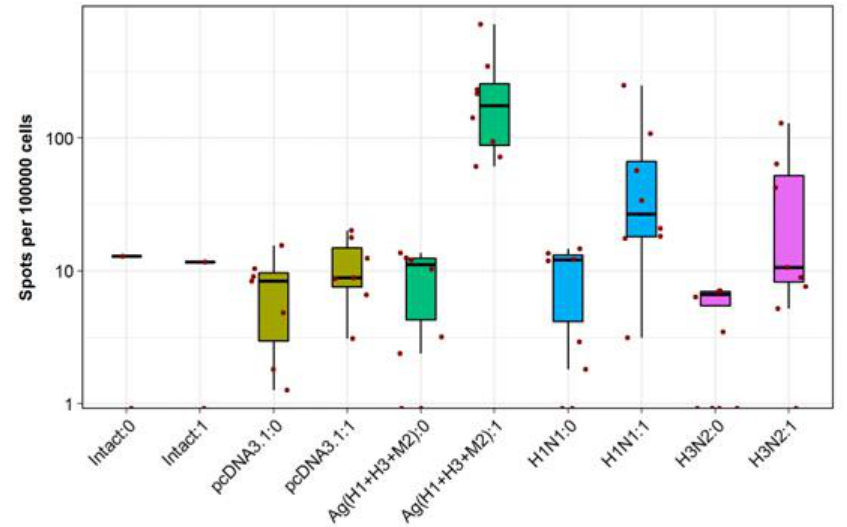
Figure 7. Evaluation of cellular responses in immunized mice using the IFN- γ -ELISpot assay. Distinct colors designate the results observed in di ff erent experimental and control groups. “0” in the name of a group corresponds to a spontaneous IFN- γ secretion, and “1” corresponds to IFN- γ secretion stimulated with antigenic peptides. Cell counts are presented on a log scale (10 base).